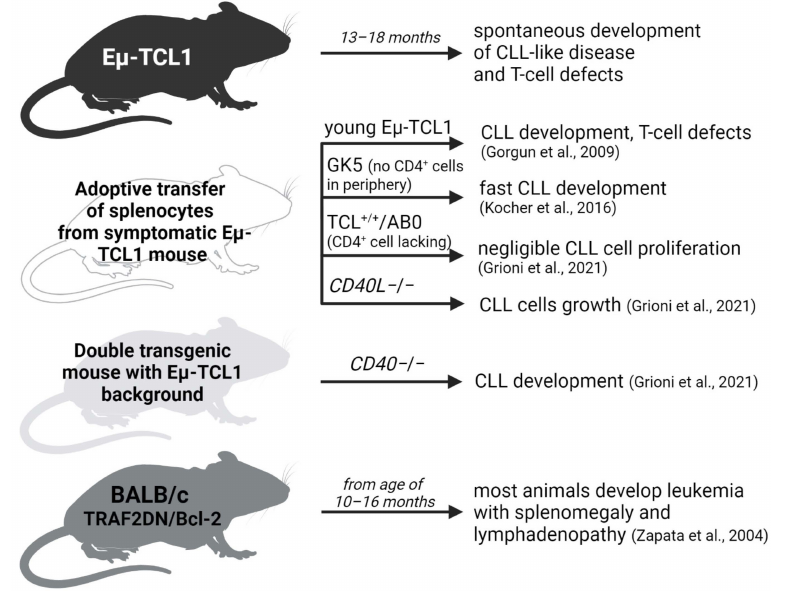
Figure 3. Transgenic mouse models exploring the role of CLL–T-cell interactions